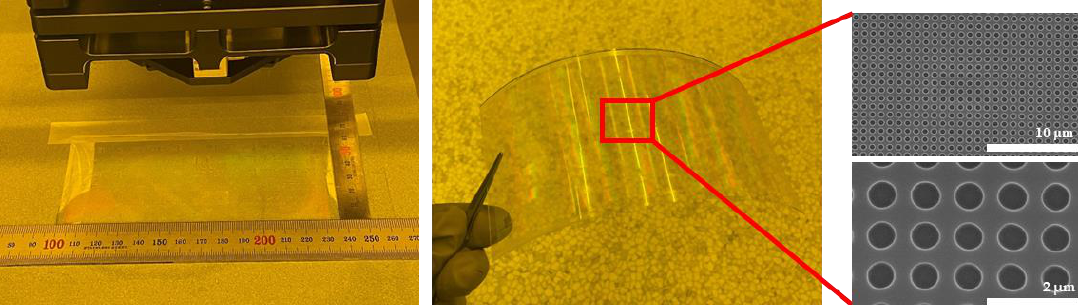
Figure 6. Results of the step-and-repeat NIL on the PET film.